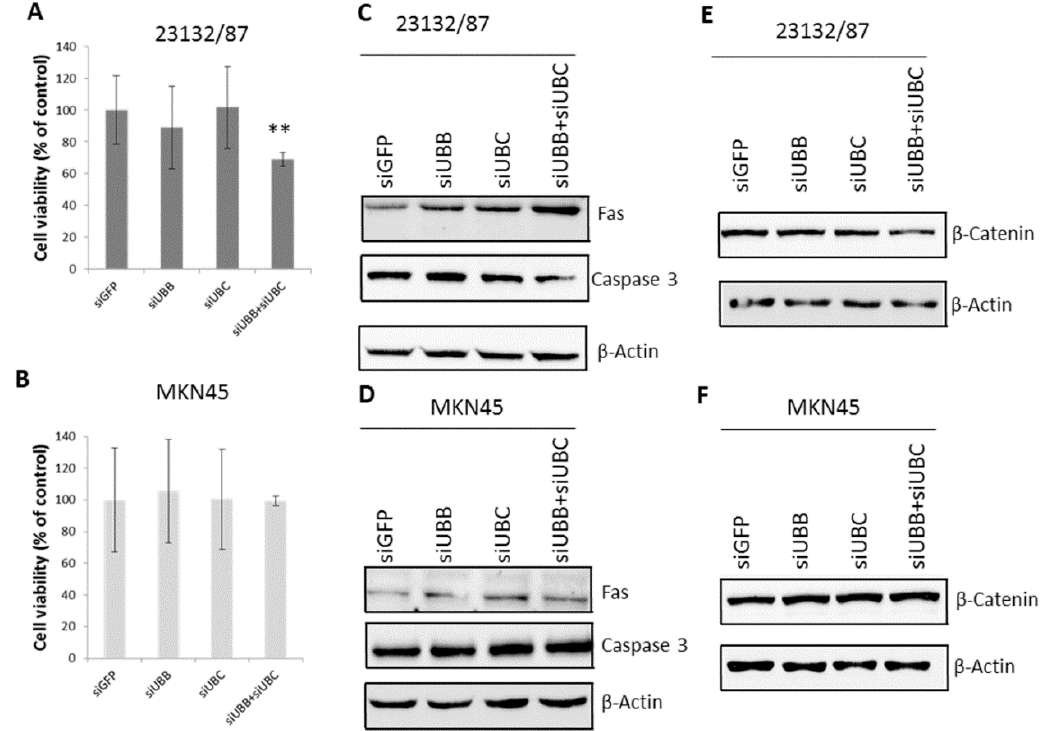
Figure 5. MTS (3-(4,5-dimethylthia-zol-2yl)-5-(3-carboxymethoxyphenyl)-2-(4-sulfophenyl)2 H - tetrazolium) assay for 23132 / 87 and MKN45 cells and evaluation of apoptotic and pro-survival markers. Cell viability of 23132 / 87 ( A ) and MKN45 ( B ) cells transiently transfected (48 h) with either si GFP (control) or with UBB , UBC or UBB + UBC siRNAs was evaluated via MTS assay ( n = 8) and shown as a percentage with respect to the si GFP transfected cells, set as 100%; ** p < 0.01. ( C , D ) Representative western immunoblots of total proteins from 23132 / 87 ( C ) or MKN45 ( D ) cells transfected as in ( A , B ), respectively ( n = 3). A quantity of 15 µ g of total cellular proteins was loaded and probed with antibodies specific for Fas or Caspase 3; blots were reprobed with anti- β -Actin, used as a loading control. ( E , F ) Representative western immunoblots of total proteins from 23132 / 87 ( E ) or MKN45 ( F ) cells transfected as in ( A , B ), respectively ( n = 2). A quantity of 7.5 µ g of total cellular proteins was loaded and probed with the antibody specific for β -catenin; blots were reprobed with anti- β -Actin, used as a loading control.